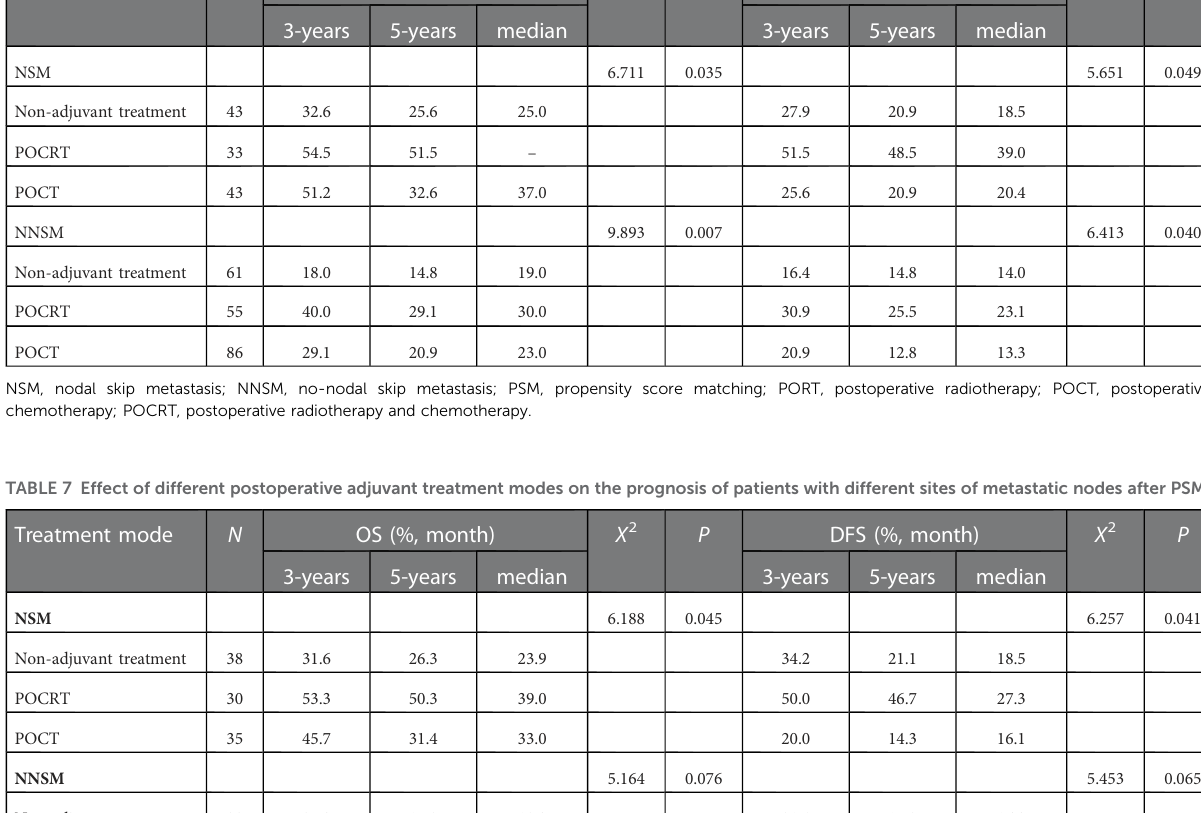
TABLE 6 Effect of different postoperative adjuvant treatment modes on the prognosis of patients with different sites of metastatic nodes before PSM. Treatment mode